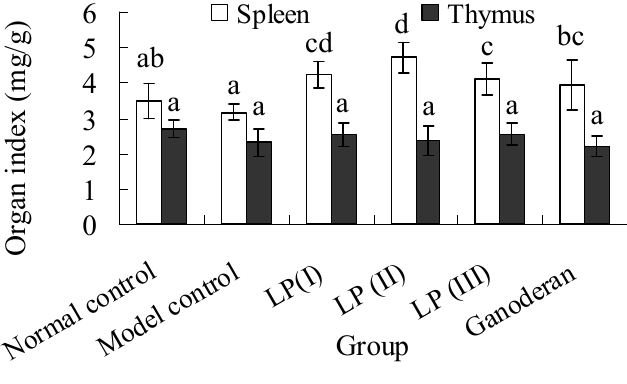
Figure 3. Effect of polysaccharide-protein complex of longan pulp (LP3) on spleen and thymus indices. Spleen/thymus index was measured in the ratio of the spleen/thymus weight (mg) to bodyweight (g). Data presented were expressed as means ± standard deviation (n = 10). The significant differences among the groups were evaluated with ANOVA followed by the S-N-K test. Columns with different letters are significantly different ( P <